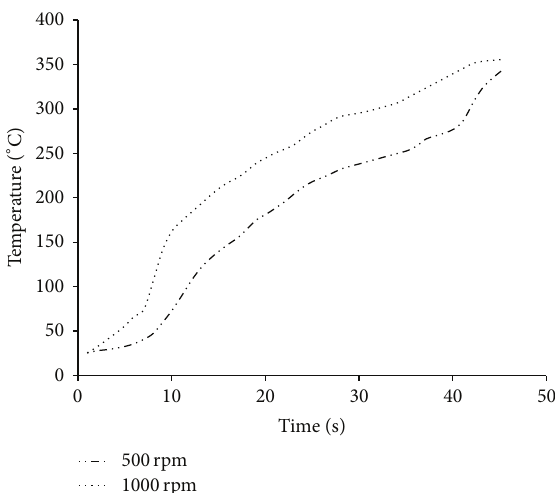
Figure 4: Penetration temperature values (pin and shoulder) for different rotational speeds.